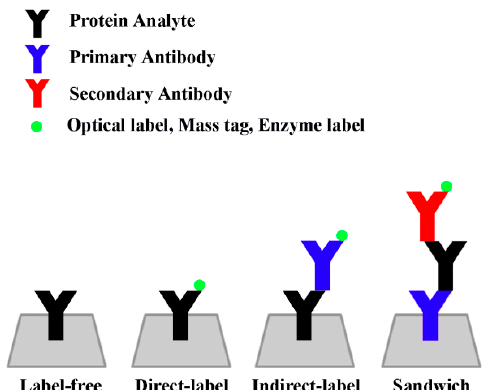
Figure 1. The different types of protein assay schemes used commonly in solid state sensor geometry. They are label-free (or direct), directly labelled, indirectly labelled, and sandwich type of assays. Labels targeting the analyte protein can be organic (fluorophores), inorganic (semiconducting nanoparticles, quantum dots, metallic nanoparticles), biological (enzymes), or mass-increasing compounds.